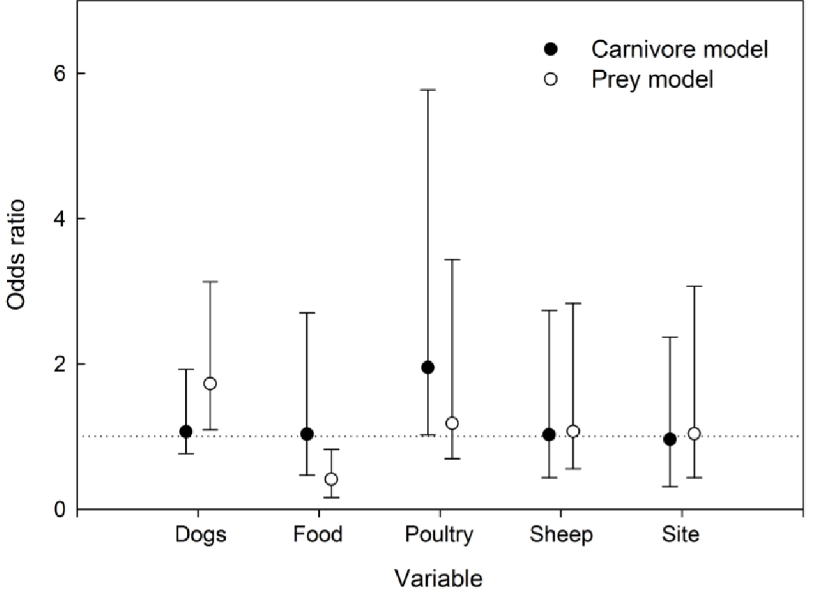
Figure 4. Model-averaged odds ratios of rural dogs interacting with carnivore and prey species. Model-averaged parameter estimates shown as odds ratios and 95% confidence intervals for explaining rural dog interactions with carnivore and prey species. Odds Ratios , 1 indicate a negative association with occurrence while Odds Ratios . 1 indicate a positive association with occurrence. doi:10.1371/journal.pone.0086152.g004 PLOS ONE |